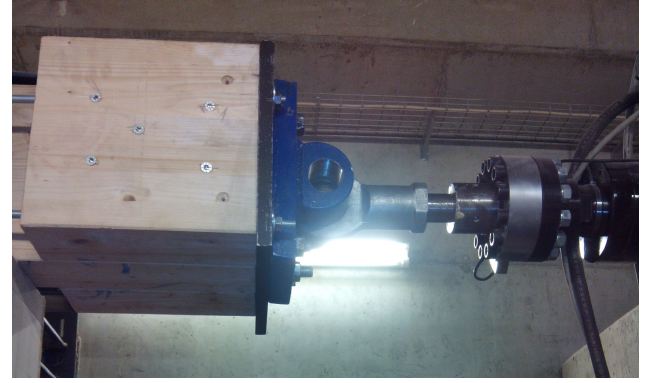
Figure 6. Detail of the fixation of the load ‐ cell to the top beam responsible for the application of the loading protocol.